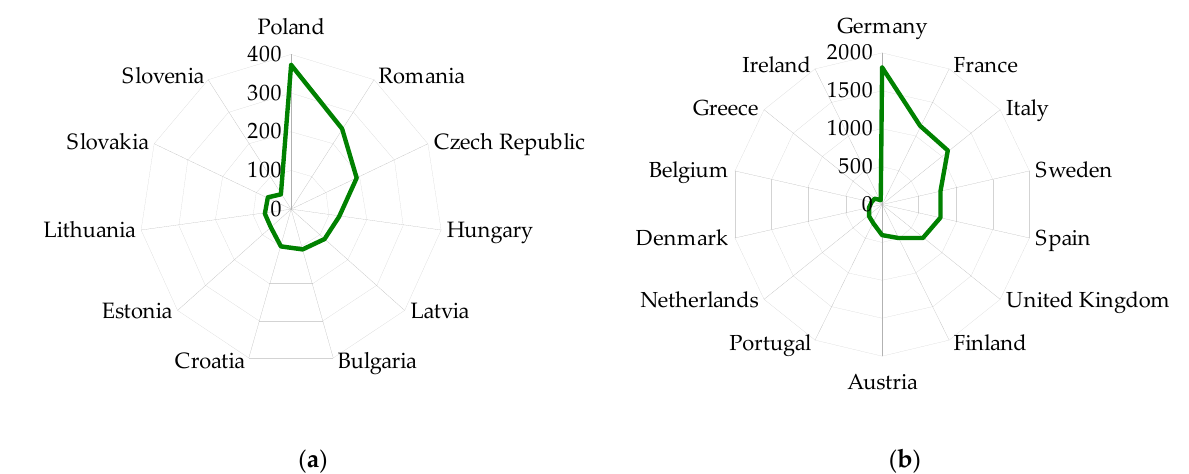
Figure 1. Renewable energy production in EU countries 2018 (PJ): ( a ) Countries that joined the EU in 2004 or later, ( b ) Countries that joined the EU before 2004. Source: Own study based on [49]. Table 4. Numerical characteristics of renewable energy production by source in EU country groups 2019 (PJ). Specification Source of Renewable Energy